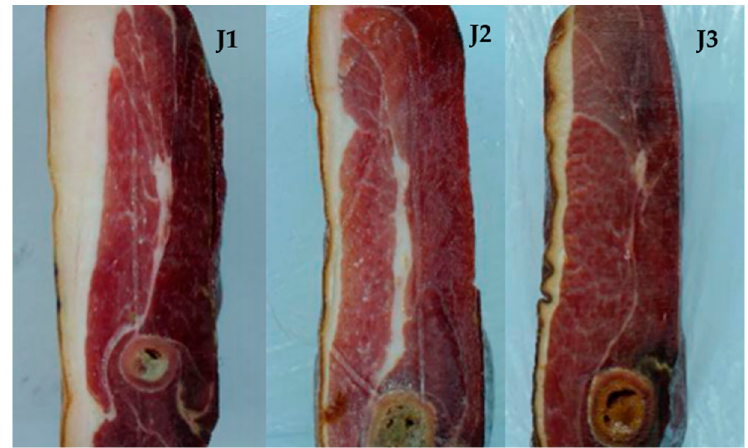
Figure 1. Jinhua ham samples aged for one ( J1 ), two ( J2 ), and three years ( J3 ).